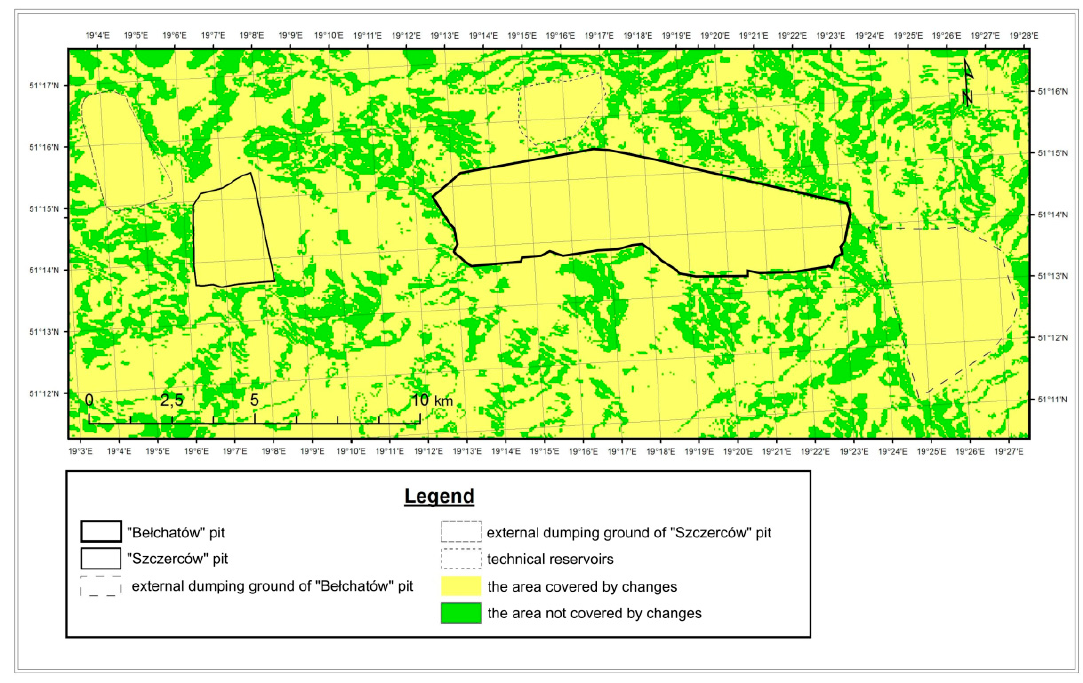
Figure 7. Raster image of areas affected by changes in surface topography. Source: Own elaboration.